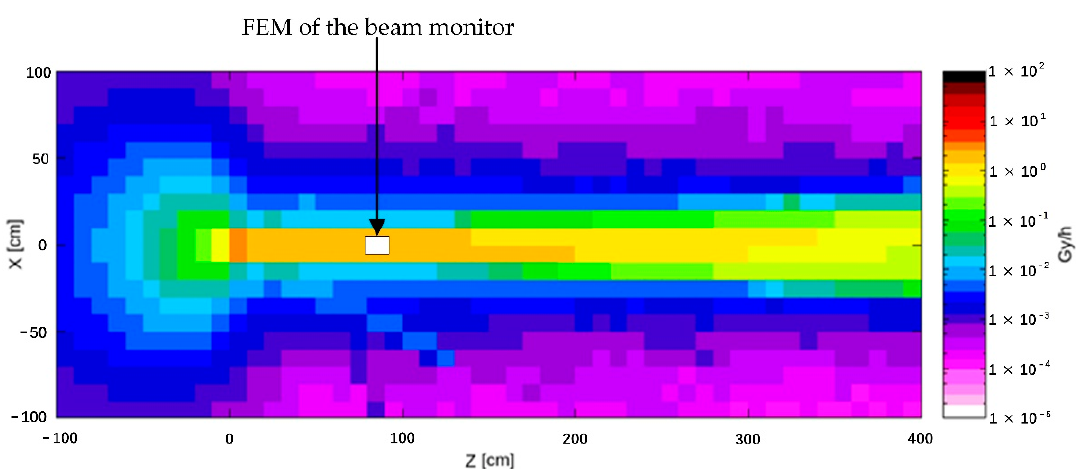
Figure 12. Simulation of distribution of secondary radiation dose rate in CEE.